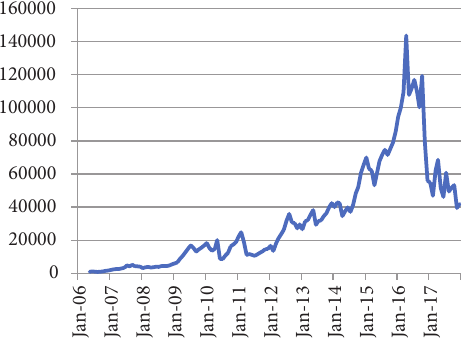
Figure 2. Volatility of monthly trading